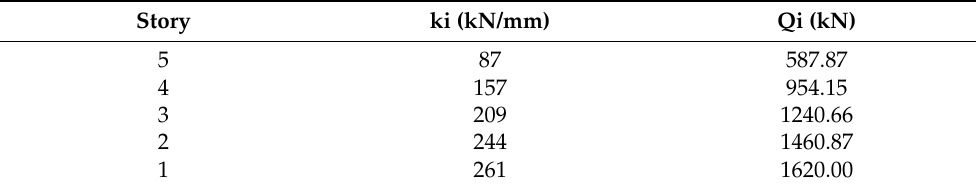
Table 4. Parameters of the bilinear hysteresis model used in the case